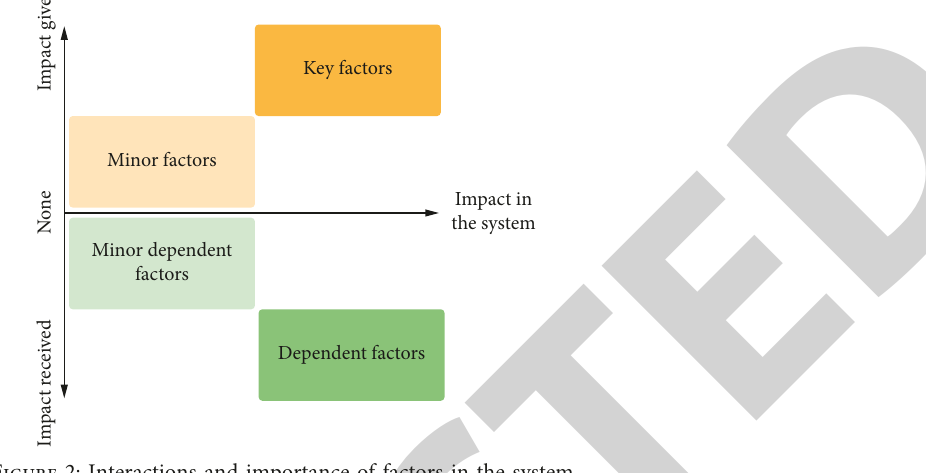
Figure 2: Interactions and importance of factors in the system.